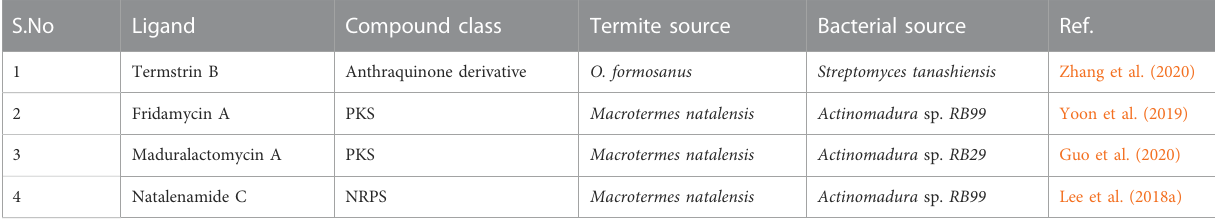
TABLE 1 The table enumerates the shortlisted NPs derived from Fungus-growing termites (novel ecological niche). S.No